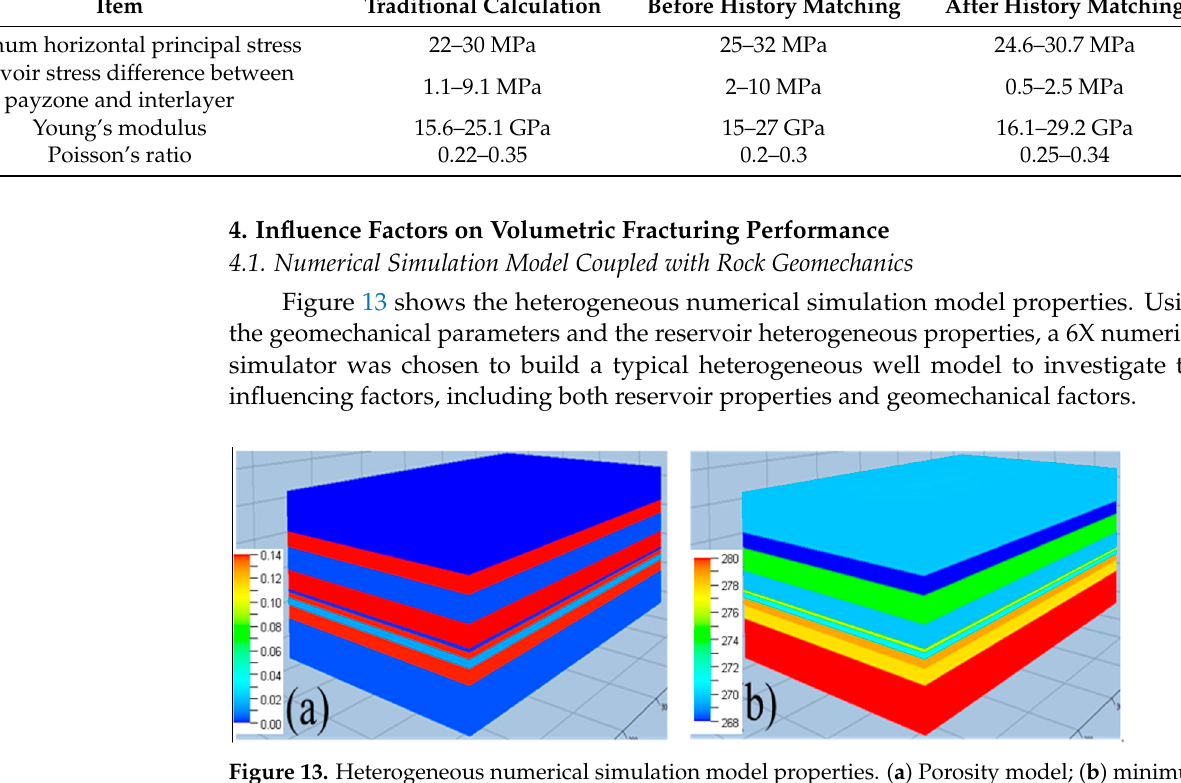
Figure 12. Spatial distribution of fractures under heterogeneous conditions.